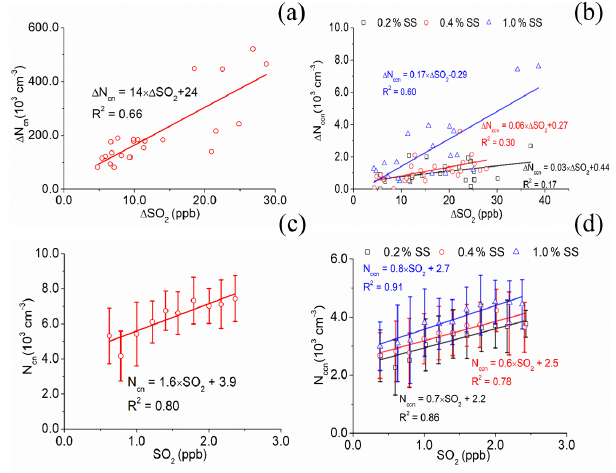
Figure 7. Relationship of hourly averaged N cn and N ccn with SO 2 at SS of 0.2%, 0.4% and 1.0%. For (a) and (b) , N cn , N ccn and SO 2 reflect the impact of the ship self-emission after the removal of the ambient concentration. For (c) and (d) , each bar indicates the standard deviation with the mean value marked as hollow circles (or triangles, squares), and the interval of SO 2 is 0.2ppb for each